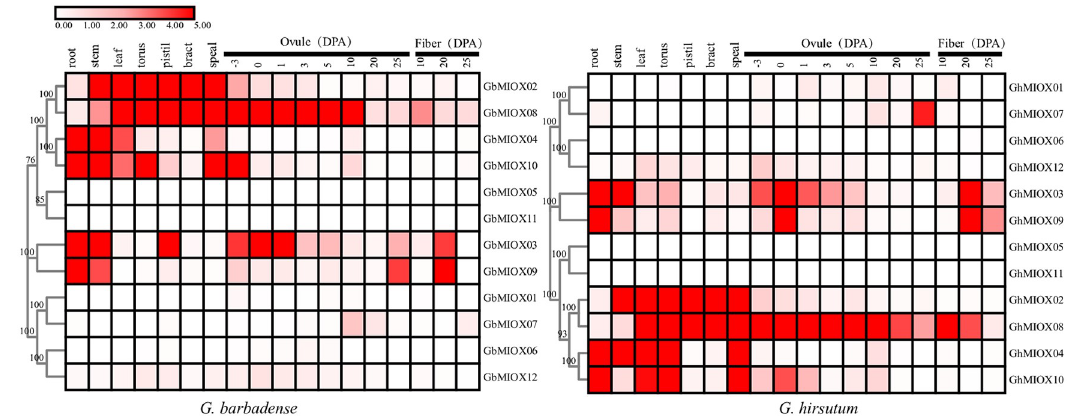
Fig 7. Expression profiles of MIOX genes in different tissues and during different developmental stages of ovule and fiber.